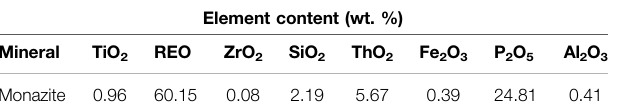
TABLE 1 | Chemical analysis results of the puri fi ed monazite. Element content (wt. %)